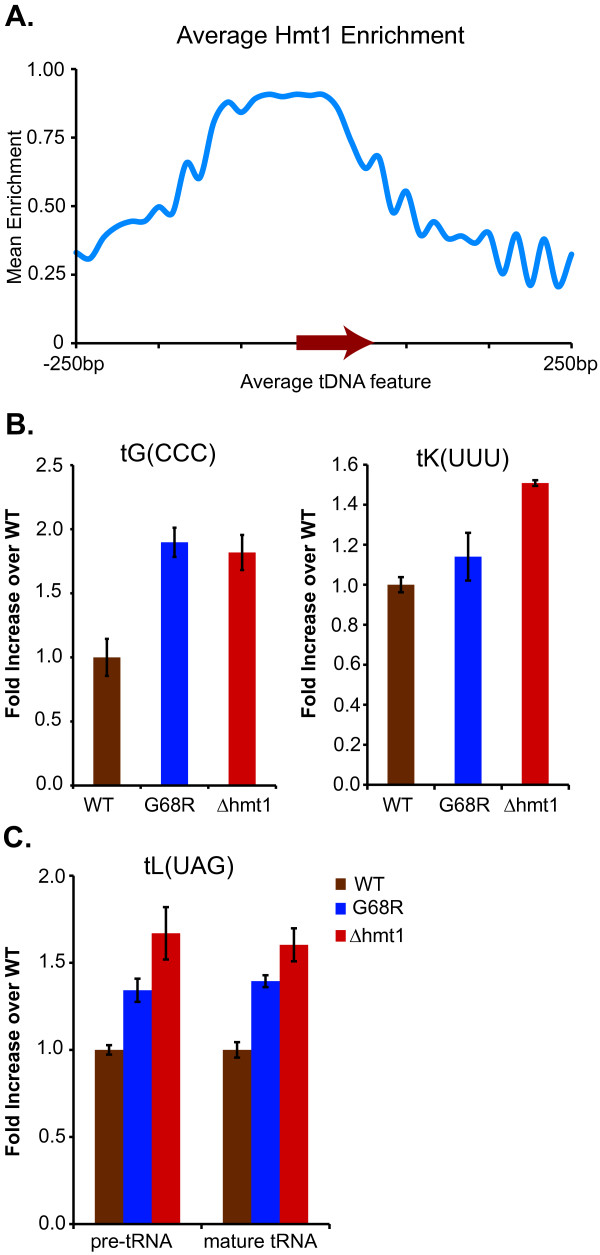
Hmt1-binding sites are enriched at tRNA genes. A) The average Hmt1-enrichment pattern across all Hmt1-bound tDNA features. B) Hmt1 loss-of-function mutants displayed increased tRNA abundance. Bar graph showing RNA hybridization analysis results on the relative abundance of mature tRNA tG(CCC) and tK(UUU) in the Hmt1-null (Δhmt1) and Hmt1-catalytically inactive mutants (G68R). Signals were normalized to the 5.8S rRNA (RNAPI transcript). C) Both pre- and mature tRNA abundance is increased in Hmt1 loss-of-function mutants. Bar graph showing RNA hybridization analysis results on the relative abundance of pre- and mature tRNA tL(UAG) in the Hmt1-null (Δhmt1) and Hmt1-catalytically inactive mutants (G68R). Signals were normalized to the 5.8S rRNA (RNAPI transcript).